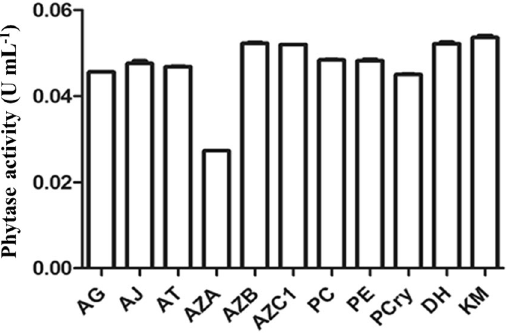
Figure 1. Phytase activity in microbial extracts of AG: Aspergillus glaucus, AJ: A. japonicus, AT: A. terreus, AZA: Acremonium zeae A, AZB: A. zeae B, AZC1: A. zeae C1, PC: Penicillium chrysogenum, PE: P. expansum, PC: P. citrinum, DH: Debaryomyces hanseniie and KM: Kluyveromyces marxianus cultured in liquid medium. The bars correspond to the standard deviations of the means (n = 3).